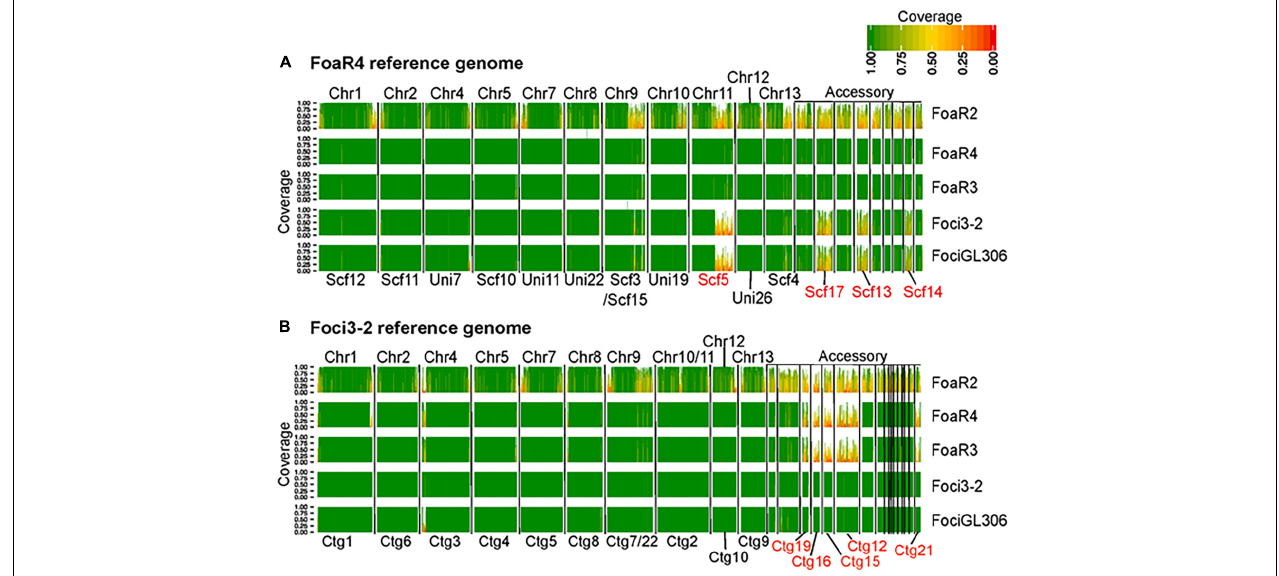
FIGURE 4 | A comparative genomic analysis showing the extent of conservation in the core and accessory genomes between F. oxysporum f. sp. apii ( Foa ) race 4 and f. sp. apii races 2 and 3, and two strains of F. oxsporum f. sp. coriandrii ( Foci ). For this analysis, we used (A) Foa race 4 and (B) Foci 3–2 as reference assemblies, based on PacBio and Illumina sequencing. For each of the five strains, we mapped 6.5 Gbp ( ∼ 100 × coverage) of quality-filtered Illumina reads onto each reference, and calculated the proportion of coverage of each 10 kbp window in the reference assemblies. Here, only contigs with a length greater than 150 kbp are shown and are separated by vertical black lines. The darkest green sections of the histogram have a 100% coverage and the reddest sections have coverage close to 0%. Coverage of 0.5 (yellow) indicates that only 5 kbp of the 10 kbp segment had Illumina coverage. The core chromosome (Chr) number of the F. oxysporum f. sp. lycopersici 4287 reference are labeled above each plot toward the left. The accessory portion of the reference genomes is indicated on the upper right of each figure. The IDs for contigs (Ctg) and scaffolds (Scf) that are associated with host specificity in our two references are lettered in red, below the plots. Each row shows the coverage from a single isolate, which is noted to the right of the graph ( Foa race 2, Foa R2; Foa race 3, Foa R3). The image is a figure from Henry et al. (2020) (BMC Genomics 21, No. 730) and is reprinted in accordance with BMC